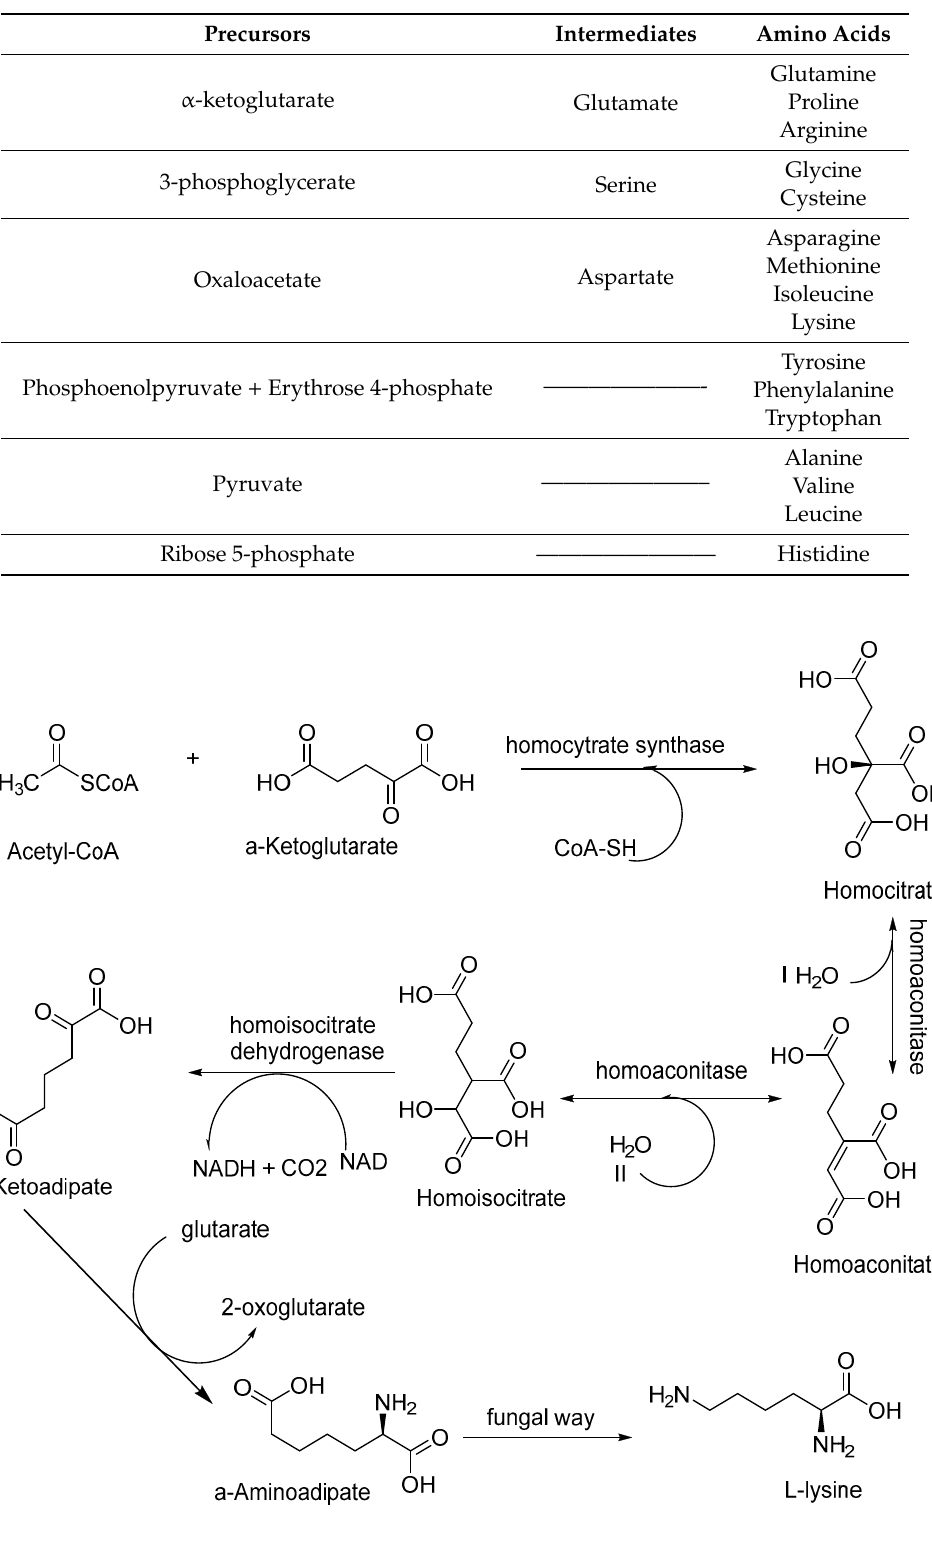
Table 1. Precursors involved in microbial biosynthesis of amino acids. Some of the amino acids mentioned in Table 3, do not involve any intermediates and their formation involves their respective precursors only i.e., serine, tryptophan, phenylalanine, valine, etc., while others, such as tyrosine and isoleucine are formed through their respective intermediates. Some amino acids also serve as intermediates in the formation of other amino acids i.e., threonine and phenylalanine serve as intermediates for isoleucine and tyrosine, respectively.